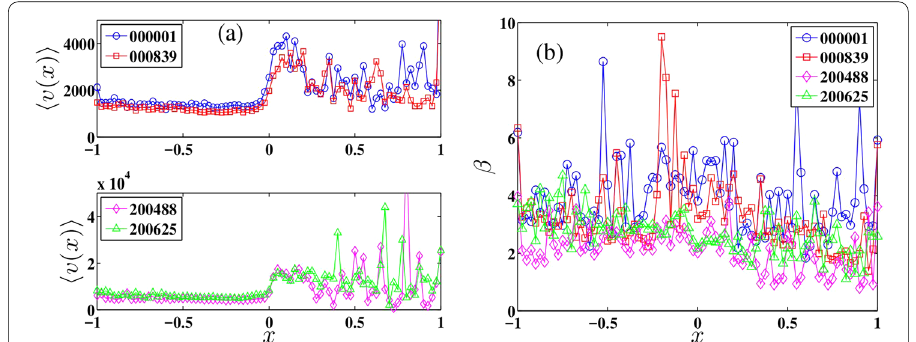
v ( x ) against the relative (cid:31) (cid:30)